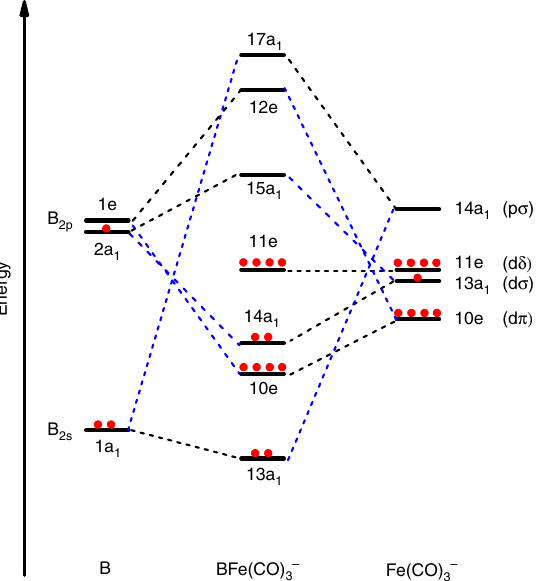
Fig. 4 Bonding scheme of the C 3v structure of 1 A 1 – BFe(CO) 3 − . The scheme qualitatively illustrates the bonding interactions between boron 2s-2p orbitals and Fe 3d/4p orbitals in the Fe(CO) 3 −